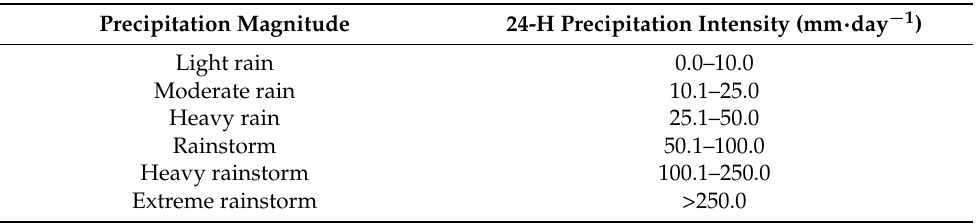
Table 3. Precipitation magnitude